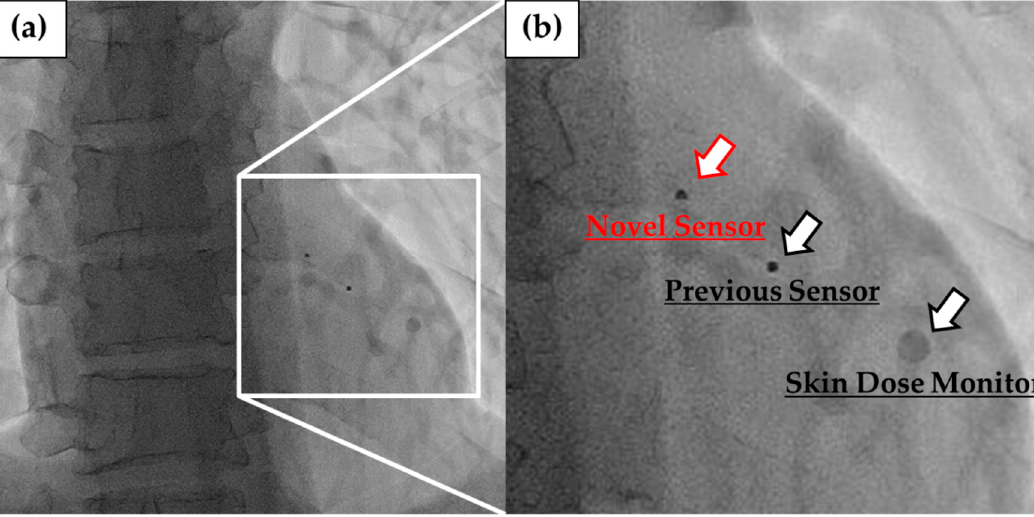
Figure 10. Comparison of with and without scatterers in the novel and previous sensors.